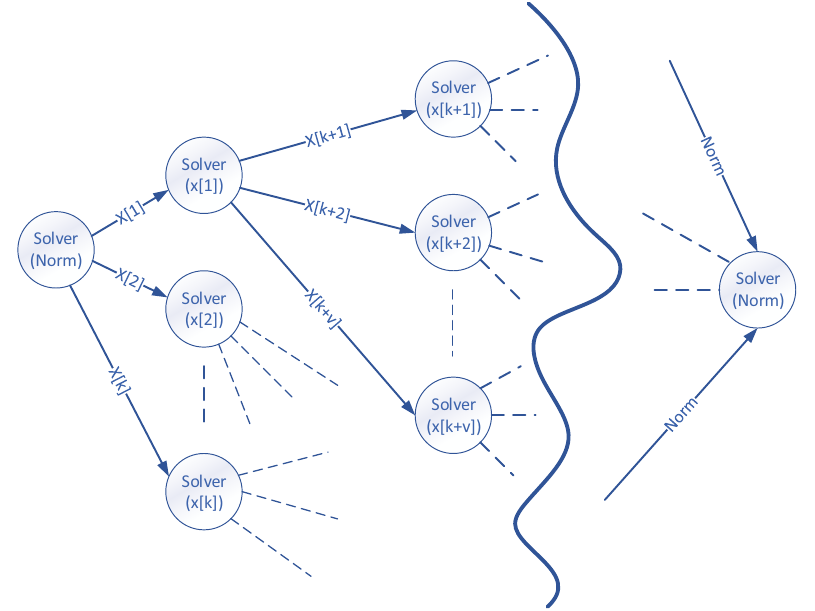
Figure 9. State space of the